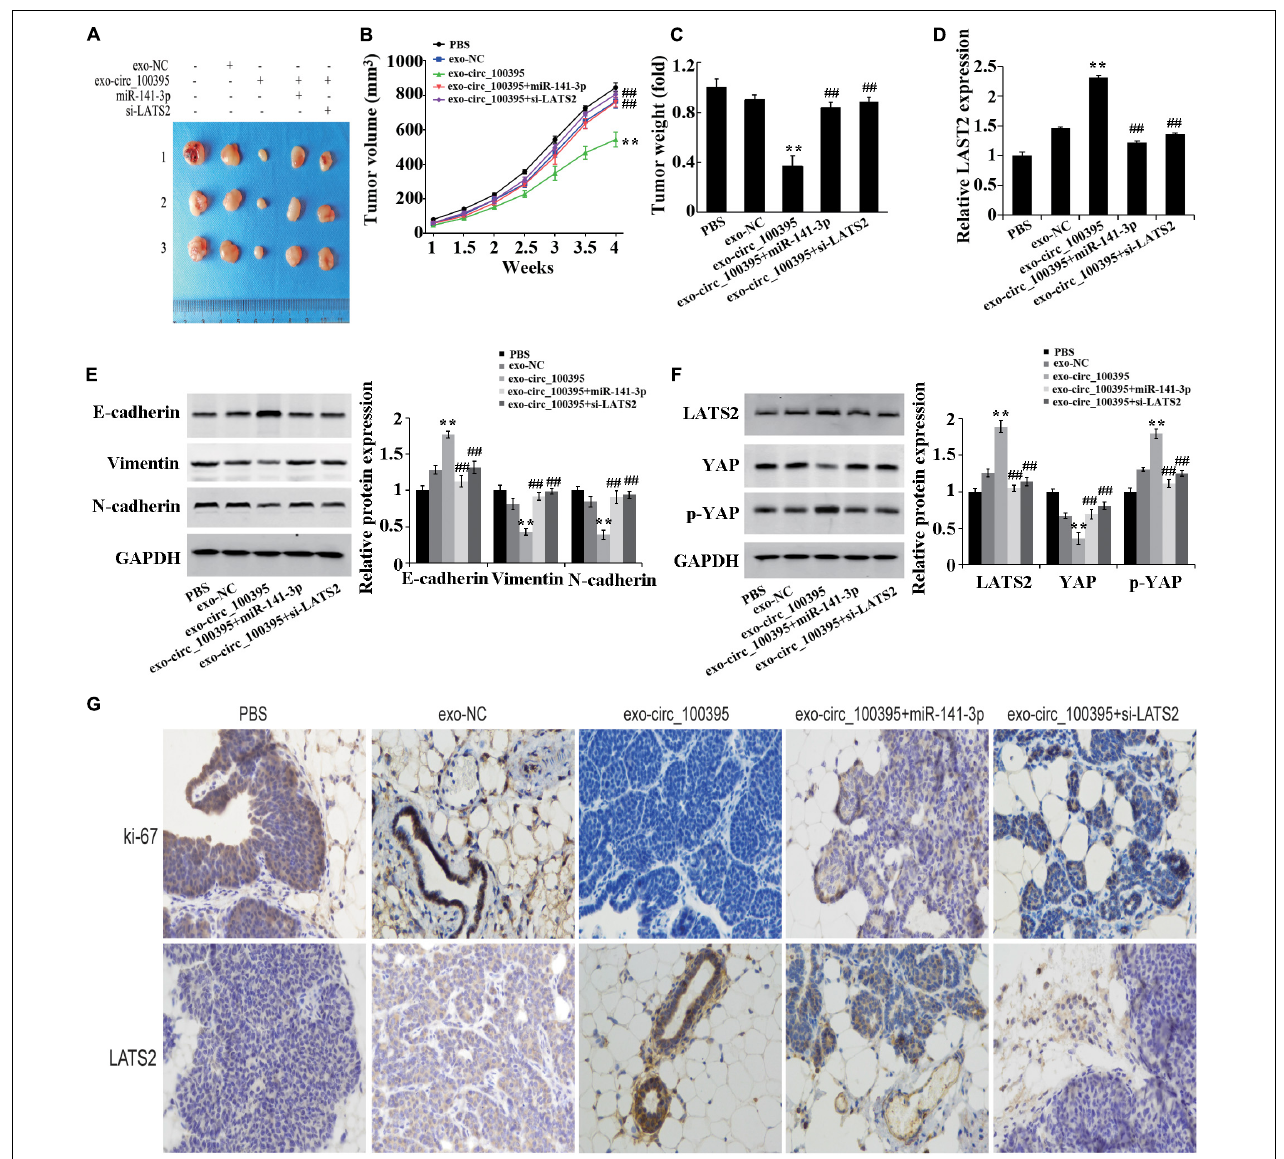
FIGURE 7 | Circ_100395 carried by exosomes from AMSCs inhibiting NSCLC in vivo growth. (A) Tumors of nude mice; (B) Line graph of the change of tumour volume; (C) Statistical graph of tumour weight; (D) Expressed LAST2 in tumour tissue analysed via qRT-PCR; (E) Expressed E-cadherin, vimentin, and N-cadherin protein detected via western blot; (F) Expressed LATS2, p-YAP and YAP protein in tumour tissues detected by western blot; (G) Expressed Ki-67 and LATS2 in tumour tissues determined by immunohistochemistry. ** p < 0.01 vs exo-NC group, ## p < 0.01 vs exo-circ_100395